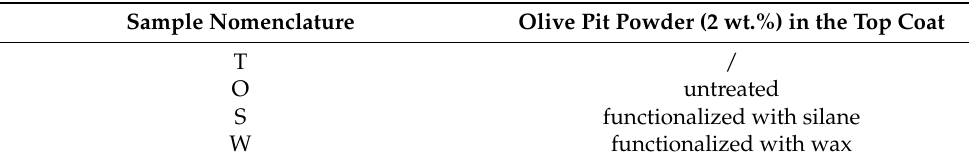
Table 1. Labelling of samples with various olive pit powder